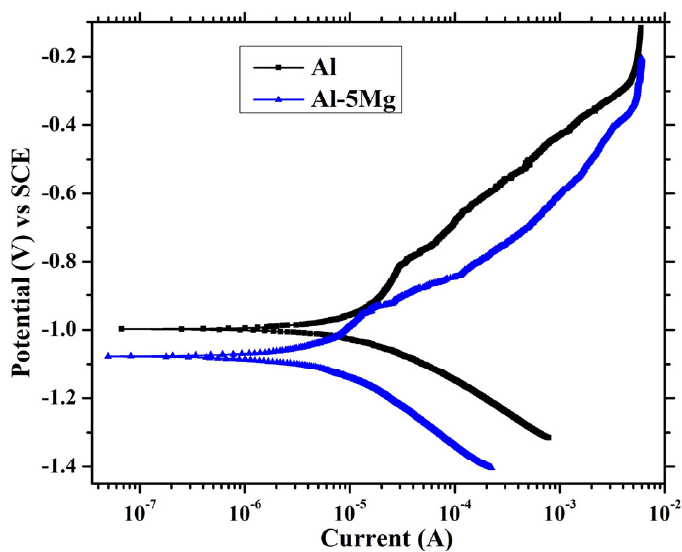
Figure 11. PDP plots of coatings after 41 d of immersion in 3.5 wt.% NaCl